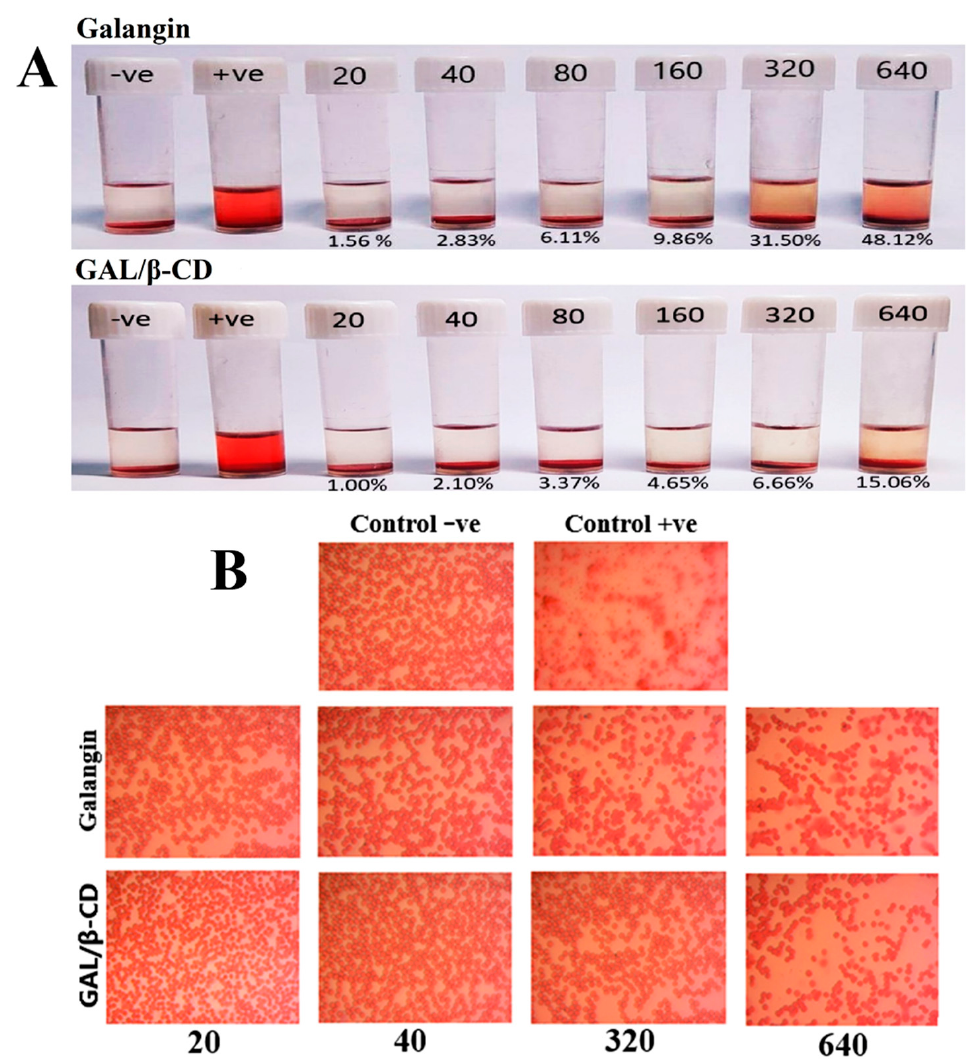
Figure 8. ( A ) Photograph of human RBCs indicating the hemolysis ratio following treatment with pure galangin and modified GAL/ β -CD at different concentrations (20, 40, 80, 160, 320, and 640 µg mL − 1 ) and ( B ) light microscopic images showing the hemolytic toxicity of pure galangin and GAL/ β -CD at concentration 20, 40, 320, and 640 µg mL − 1 , respectively. (magnification power: 40×). Control − ve, RBCs incubated with normal saline; Control +ve, RBCs incubated with D.W. In contrast, the higher concentrations of unbound galangin (80, 160, 320, and 640 µg mL − 1 ) caused hemolysis that was higher than the permissible level (6.11%, 9.86%, 31.50%, and 48.12%, respectively); however, hemolysis caused by the lower concentrations of 20 and 40 µg mL − 1 was within the permissible level (1.56% and 2.83%, respectively). Due to